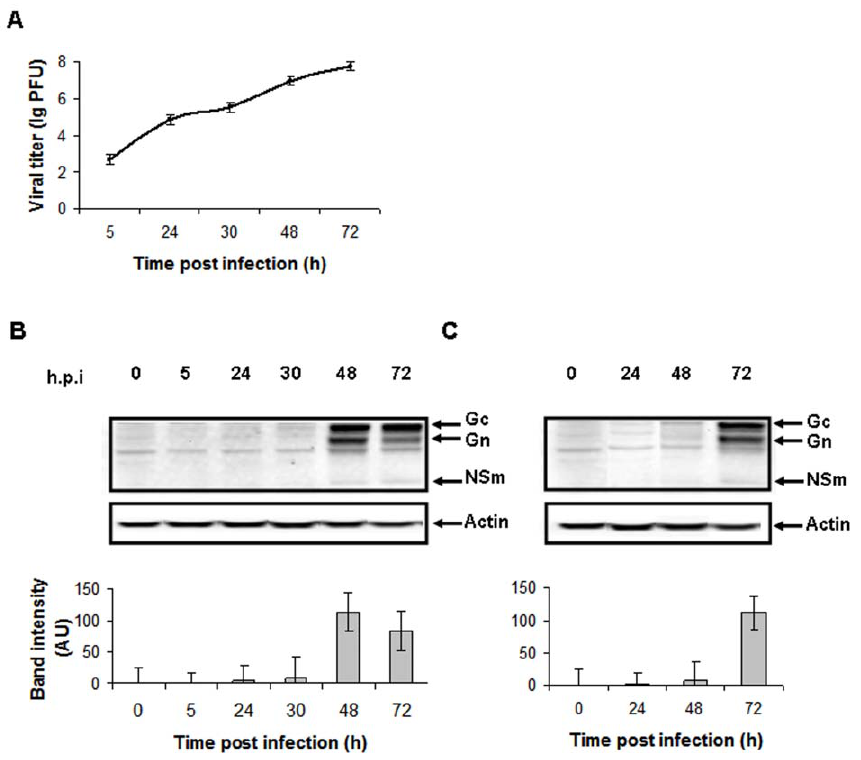
Figure 1. Quantitative analysis of the newly-formed virus released from HSAECs into culture supernatants. A. Plaque assay data are presented as lg (PFU/ml) in supernatants of RVFV-infected HSAECs for MOI of 0.002. B, C. Western blot of lysed cells using antibodies against peptide from the middle of RVFV M segment and against actin (B, for MOI of 0.002 and C, for MOI of 0.0002). The amount of cells loaded was 1.4 6 10 4 cells per well. Band intensities (arbitrary units) of viral proteins above the background detected in uninfected cells are shown as graphs below of Western data. The positions of Gc, Gn and NSm proteins translated from the M-segment are shown with arrows.